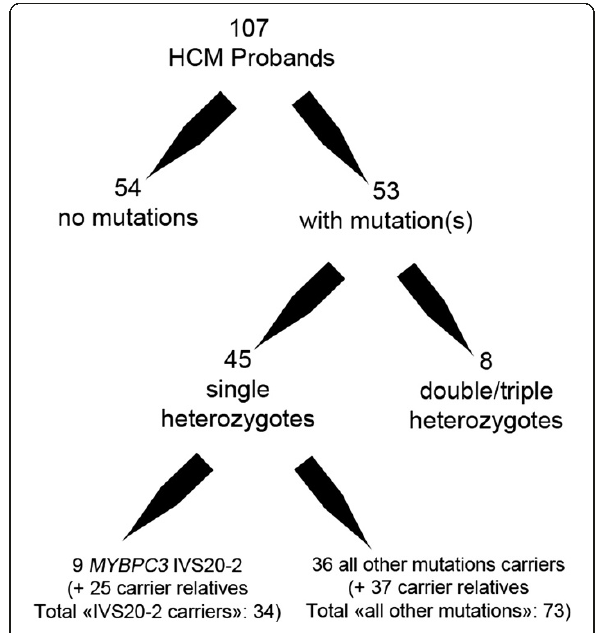
Figure 1 Scheme summarizing the sorting process of HCM